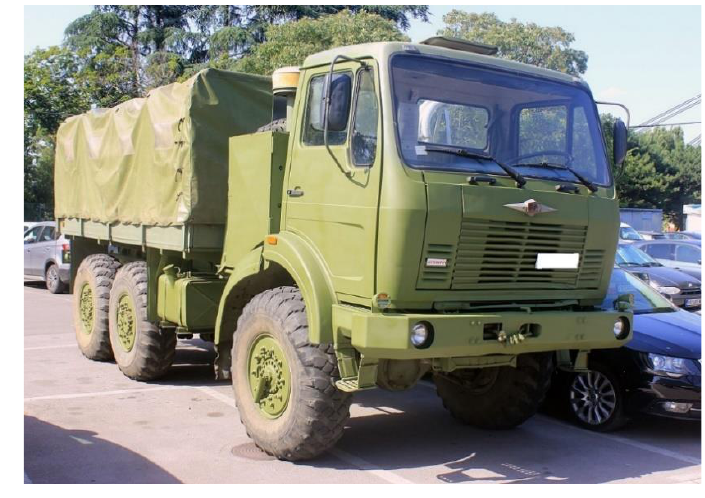
Figure 2 – All-terrain vehicle FAP 2026 Рис. 2 – Крупнотоннажный грузовой автомобиль ФАП 2026 Слика 2 – Теренско возило ФАП